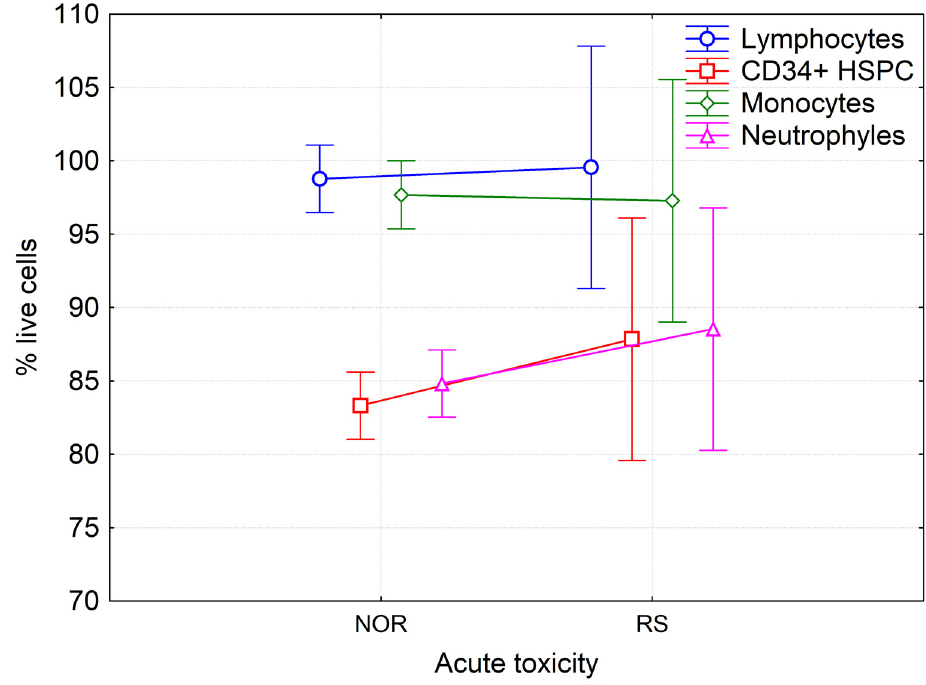
Figure 4. Percentage of live lymphocytes, monocytes, neutrophils and hematopoietic stem/progenitor cells in peripheral blood of BC patients before RT. Mean values from forty-seven NOR patients (G0-G1) and four RS (G2) patients along with 95% confidence interval are shown.